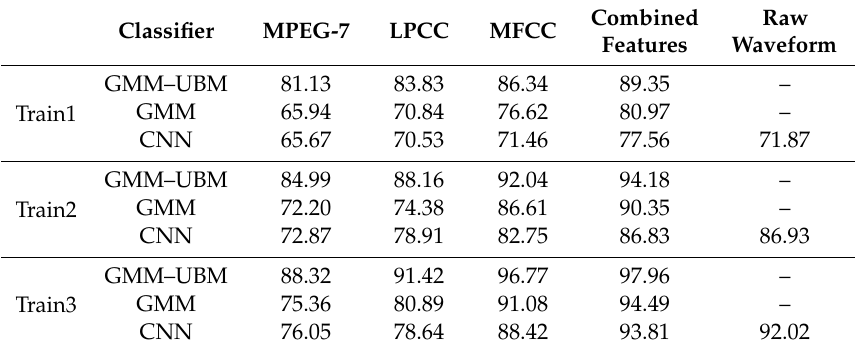
Table 6. Accuracy of violin grade classification (%).